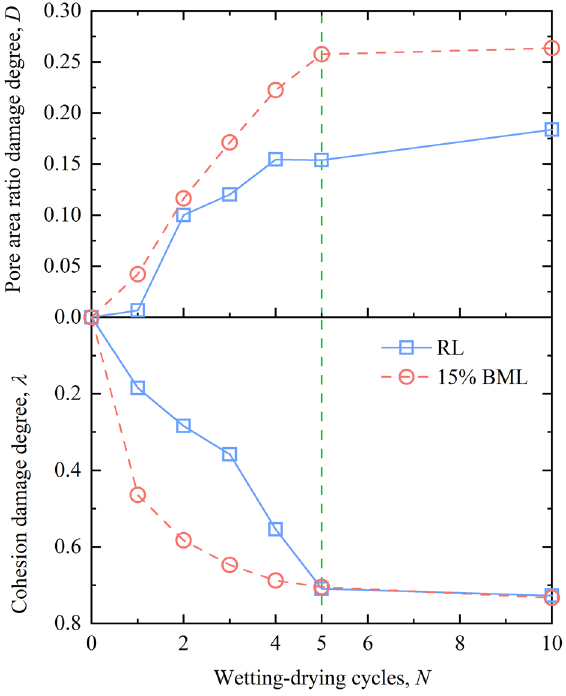
Figure 16. Comparison of damage degree of loess under W–D